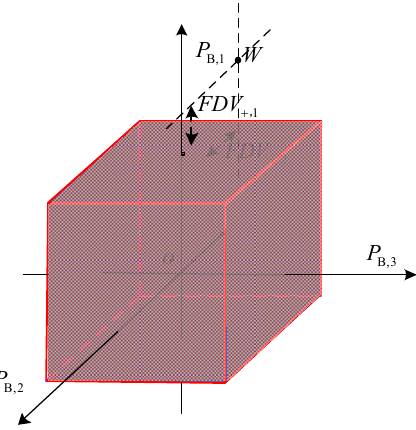
Figure 1. The FDVs for DN with 3 lines.